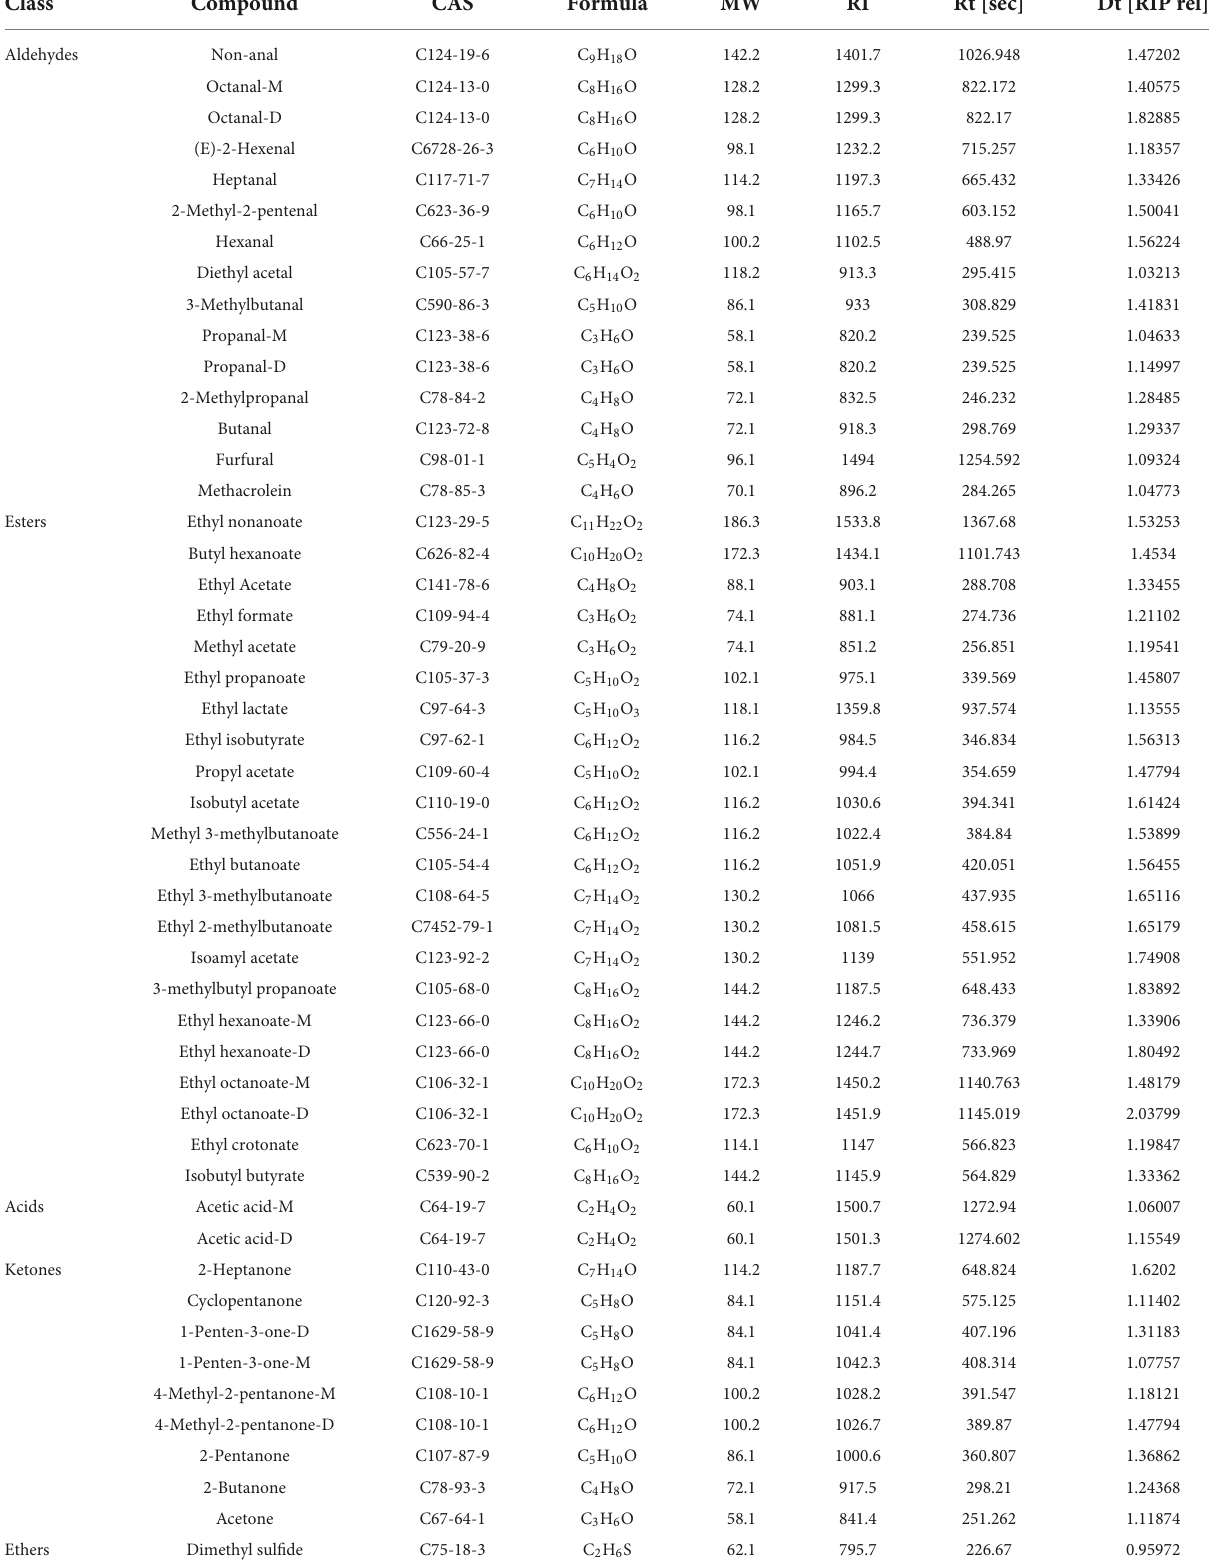
TABLE 2 Qualitative analysis of volatile compounds in the grapefruit